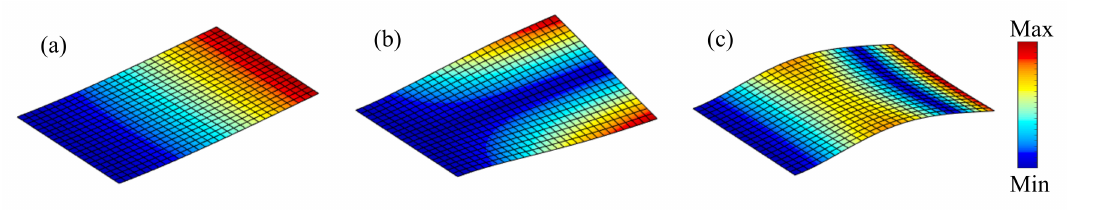
Figure 6. The first three eigenmodes of the cantilever composite plate. ( a ) The first eigenmode at 75 Hz. ( b ) The second eigenmode at 255 Hz. ( c ) The third eigenmode at 467 Hz. First, the effects of the different initial microstructures and excitation positions are studied. The excitation frequency range is set to 0~60 Hz. Four different cases are con- sidered, including (a) the excitation position is at P A and the initial guess 1 is used for the microstructure design, (b) the excitation position is at P A and initial guess 2, (c) the excitation position is at P B and initial guess 1, and (d) the excitation position is at P B and initial guess 2. In all the four test cases, the volume fractions in both scales are the same, which are f MA = 0.5 and f MI = 0.6. When f MI = 0.6, the volume fraction of the damping material A (rubber) is v MI,1 = 60%. Note that v MI,1 + v MI,2 = 1.0, thus the volume